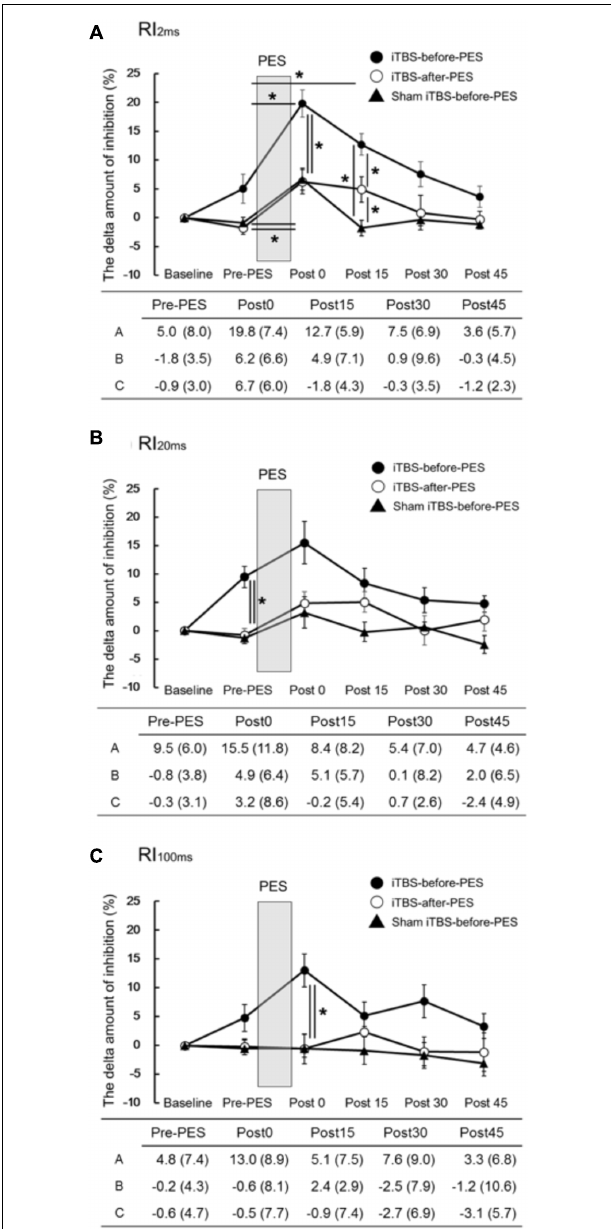
FIGURE 2 | The effects of iTBS before and after PES on RI (A–C) . The values (%) of RI 2ms (A) , RI 20ms (B) , and RI 100ms (C) indicate the delta amount of inhibition, which was calculated by subtracting the values obtained at each testing time point from the baseline values. The values are presented as the mean ± standard error of the measurements in the figure and as the mean (SD) in the table. In the table, A shows iTBS-before-PES, B shows iTBS-after-PES, and C shows sham iTBS-before-PES. Asterisks indicate significant differences ( P < 0.05) between Pre-PES and each intervention time point, or within the